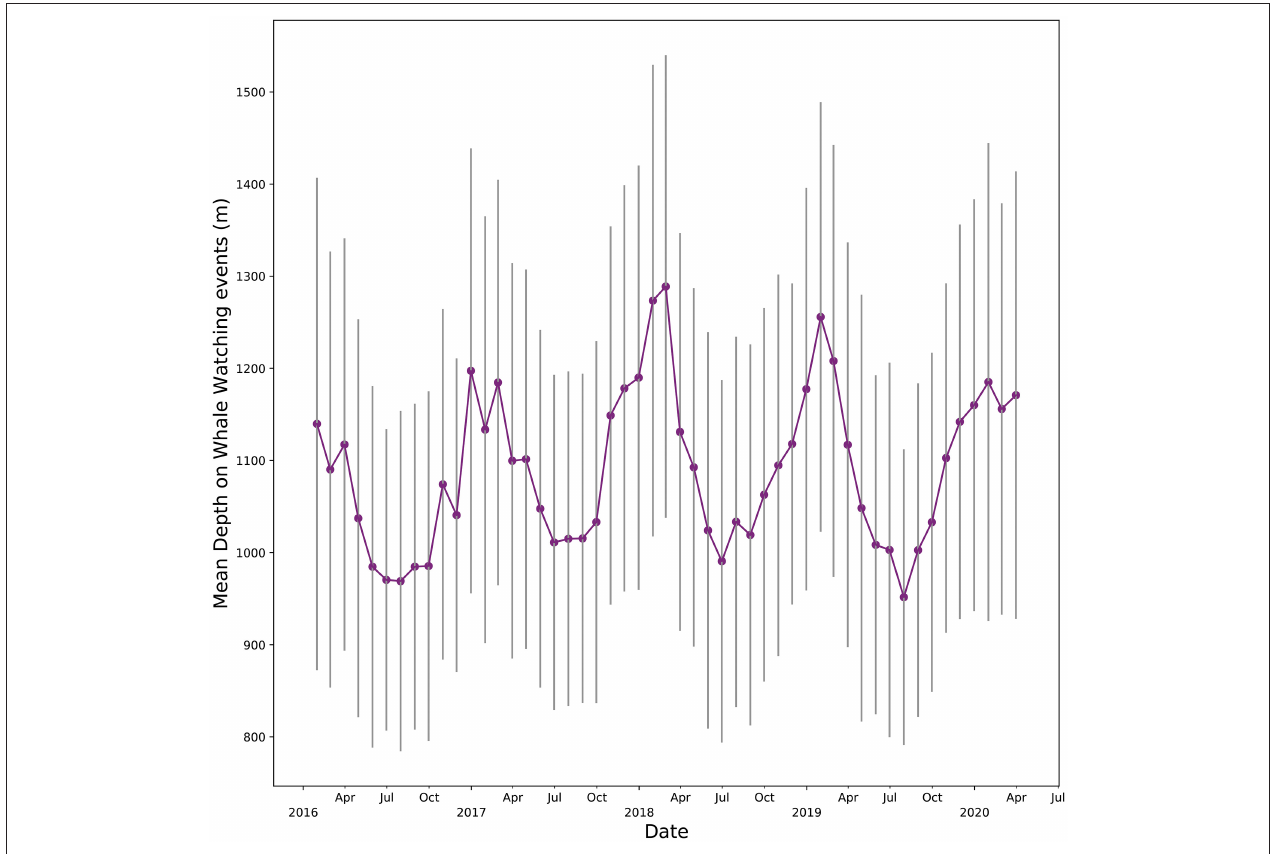
FIGURE 8 | Mean monthly depth of the whale watching activities off south Tenerife during the study period (red line). Gray lines indicate